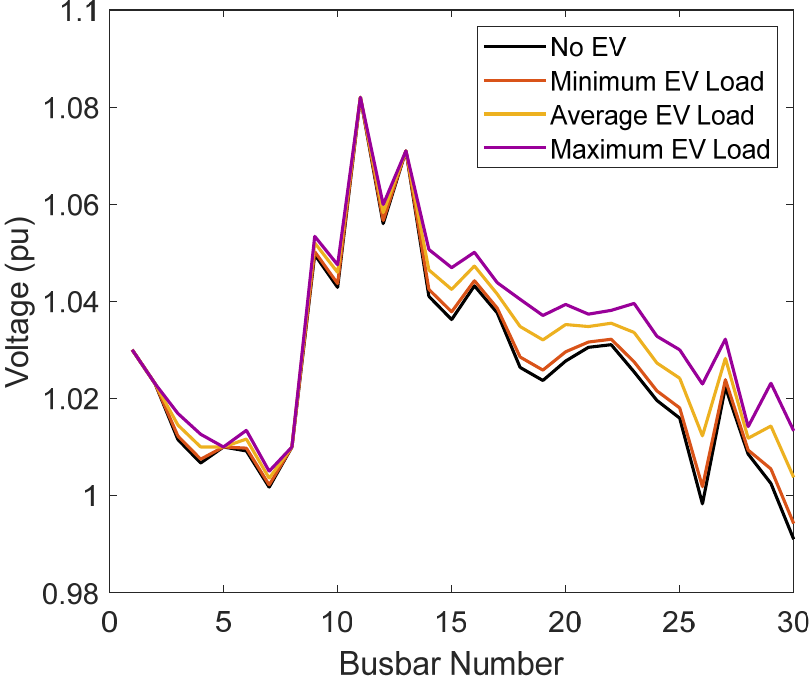
Figure 12. The voltage profile of the IEEE 30 bus system with the use of the SEVCS with different load variations with using the DR or the V2G concepts.